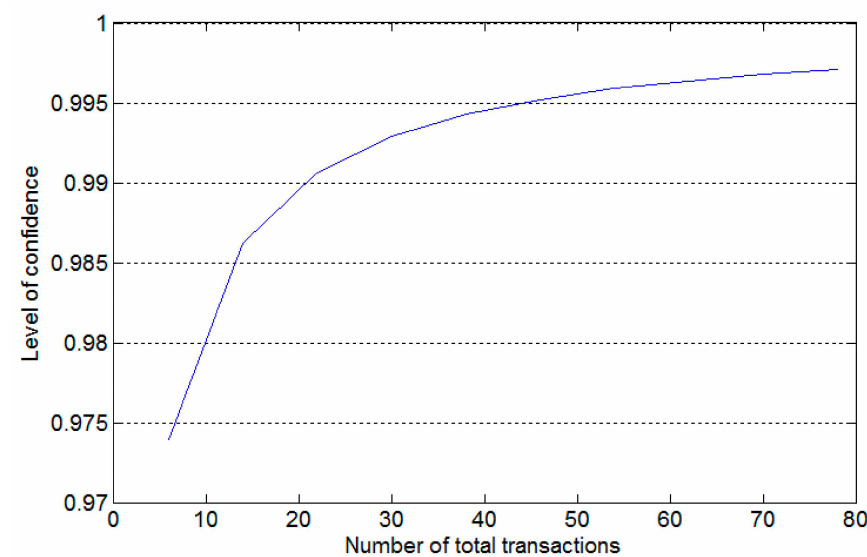
Figure 4. The relationship between level of confidence and transaction